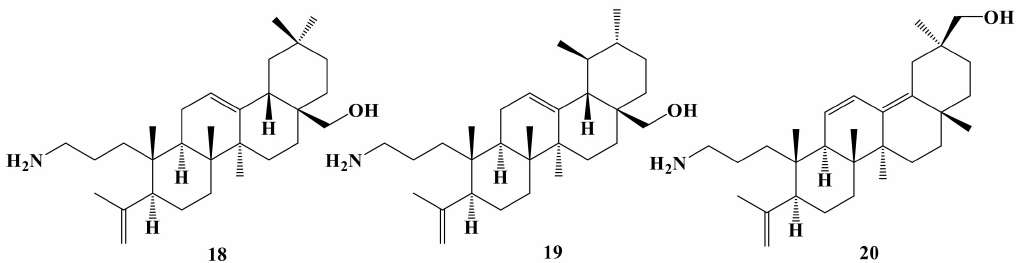
Figure 4. 3-Amino-3,4-seco-4(23)-en triterpenic derivatives of erythrodiol 18 , uvaol 19 and glycyrrhetol-dien 20